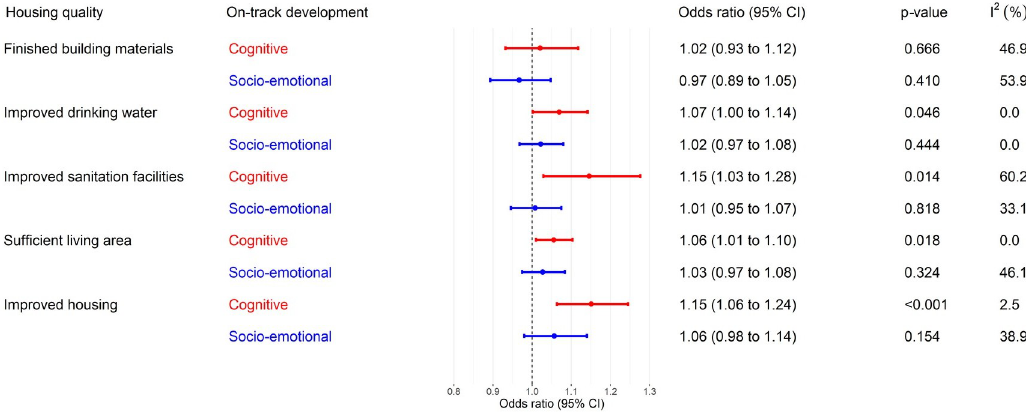
Fig 1. Association between housing quality and ECD in children aged 36–59 months in SSA. AU : Query 4 test (cid:0) Theterm } p (cid:0) value } hasbeenusedthroughoutthetext : Toenforceconsistencyinthepaper ; pleaseprovideanupdatedFig 1 filewith } Pvalue } replacedwith } p (cid:0) value } : Odds ratios are adjusted for age (months) and gender of the child, maternal education, household wealth index, and the availability of children’s books and playthings. CI, confidence interval; ECD, early childhood development; SSA, sub-Saharan Africa.